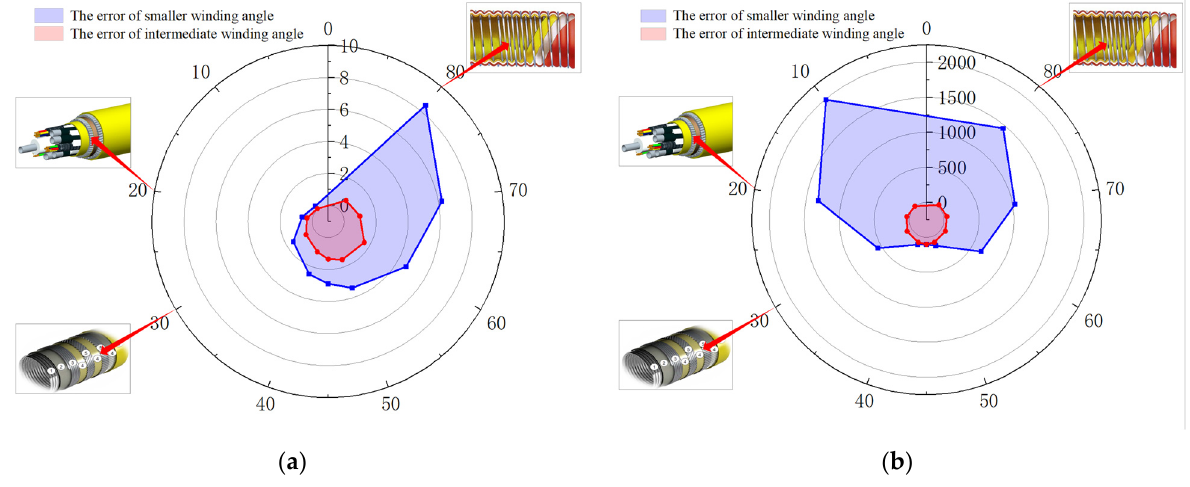
Figure 12. Error comparison. ( a ) Normal stress error, ( b ) shear stress error.